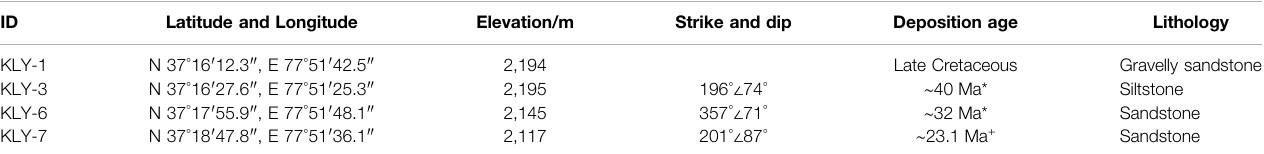
TABLE 1 | Sampling information for the Keliyang Section in the SW Tarim Basin. The* symbol represents ages based on high precision magnetostratigraphy from Sun et al. (2016a); and the+symbol represents ages constrained by the youngest detrital zircon U/Pb age. ID